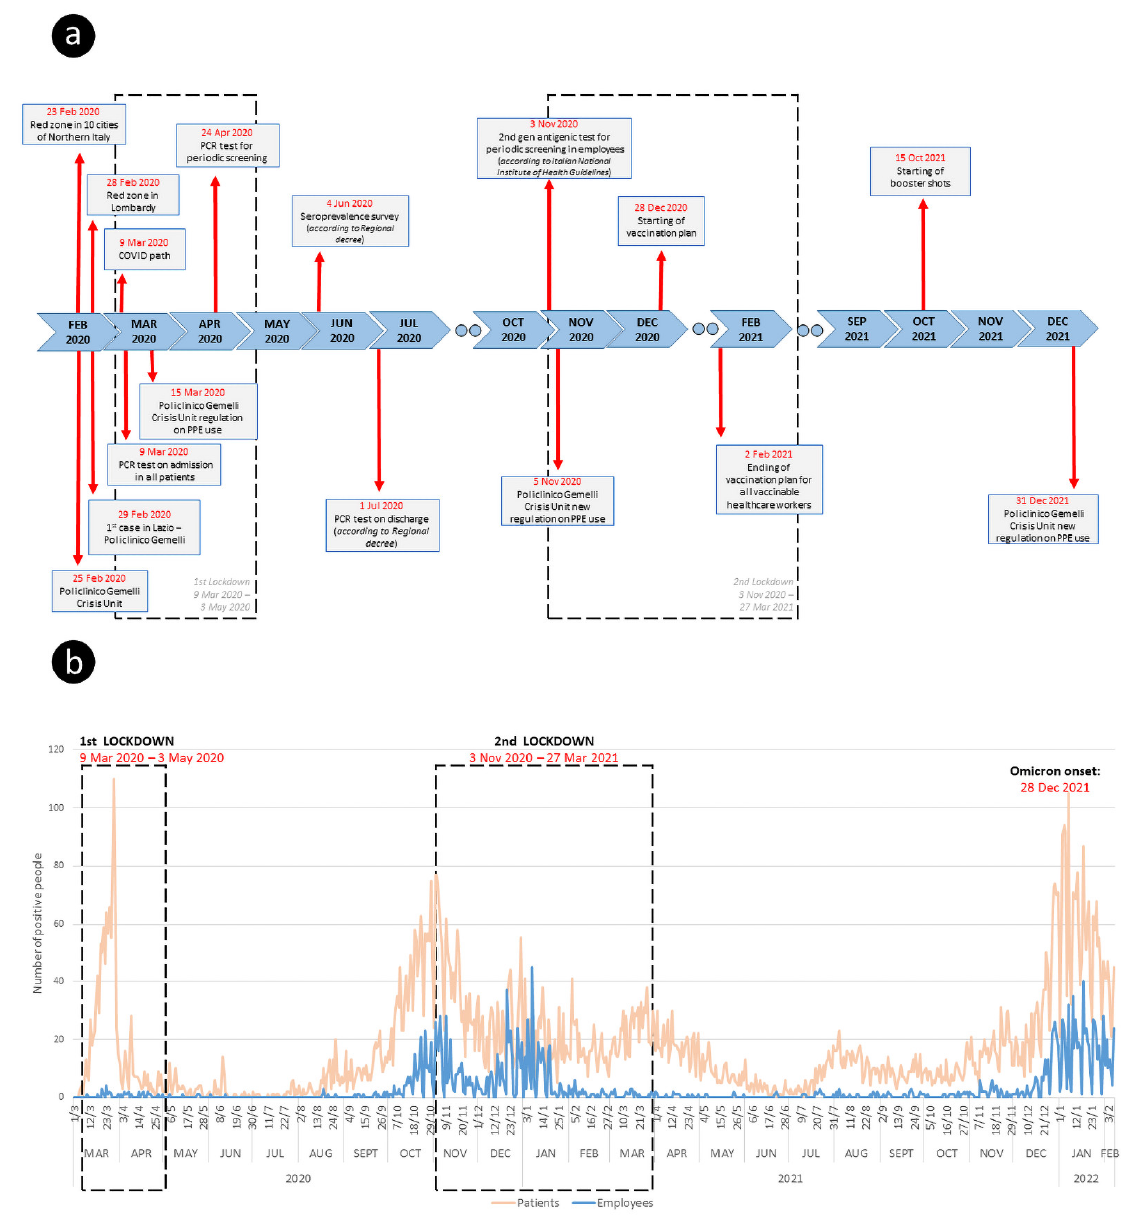
Figure 1. ( a ) Timeline representing both interventions based on National/Local Health Authorities and measures adopted in our Institution; ( b ) The trend of infections and positivity in the staff group and the patient group admitted to our Institution.